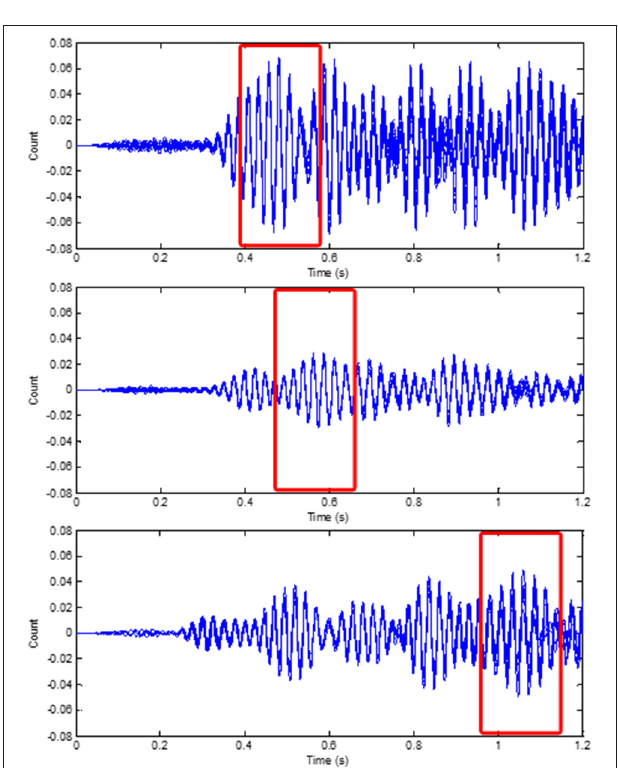
FIGURE 3 | Three air gun shot sequences from the Greenland II recorder. All images show the pulses detected in a single run file (2 min) synchronized using cross correlation with the first pulse in the recording. The top two ones were fired from a distance of 20 km, the bottom one from 50